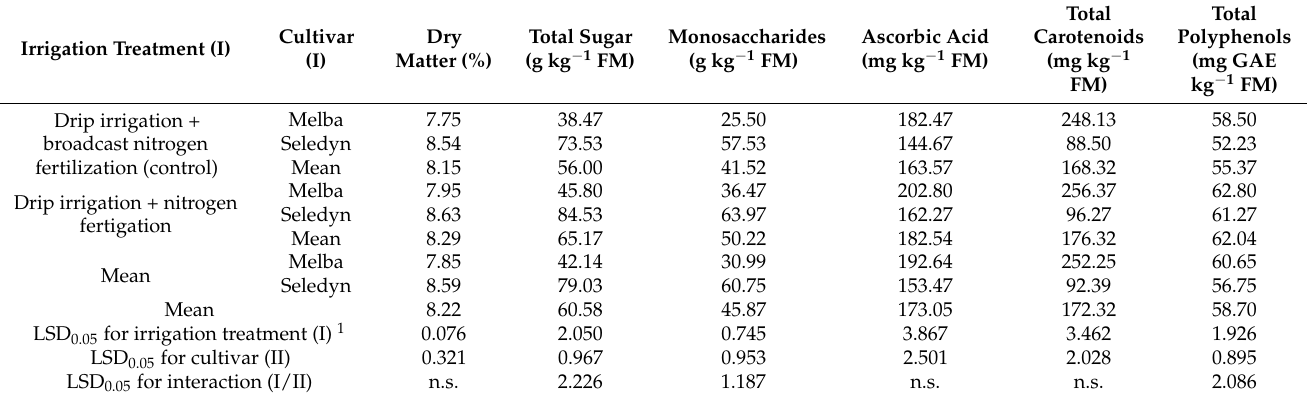
Table 5. Influence of drip fertigation on the selected components of nutritive value of Melba and Seledyn melon cultivars (mean for the years